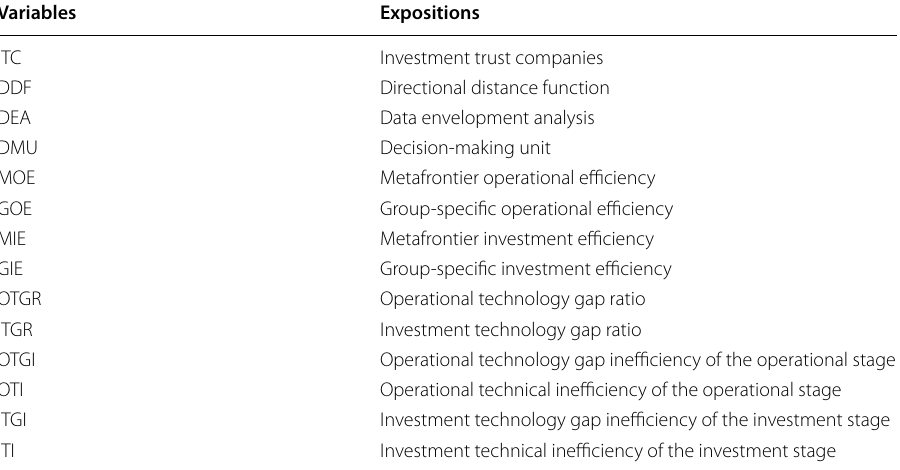
Table 9 Abbreviations of DEA‑related terms and their expositions